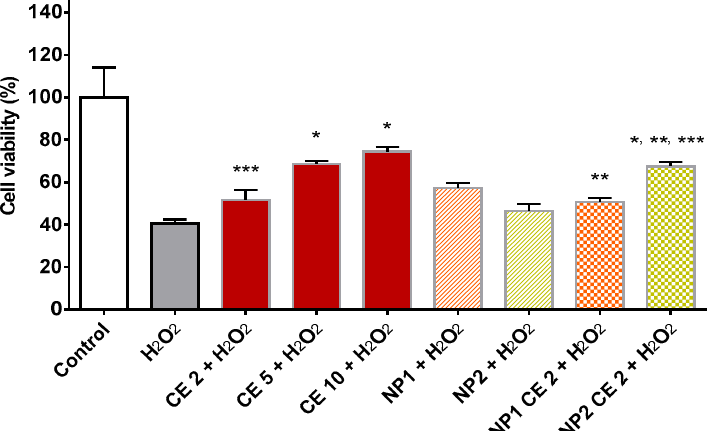
Figure 5. HUVEC viability after 2 h of pre-treatment with free CE (2, 5, 10 µ g/mL GAE), empty NP1 or NP2, or CE-loaded NP1 or NP2 (CE concentration 2 µ g/mL GAE), and the subsequent treatment with 50 µ M H 2 O 2 for 1 h. Data are expressed as % viable cells compared to negative control (H 2 O 2 ). *, significantly different from H 2 O 2 ; two means at comparison are indicated by the same mark (** or ***) if their difference is significant.